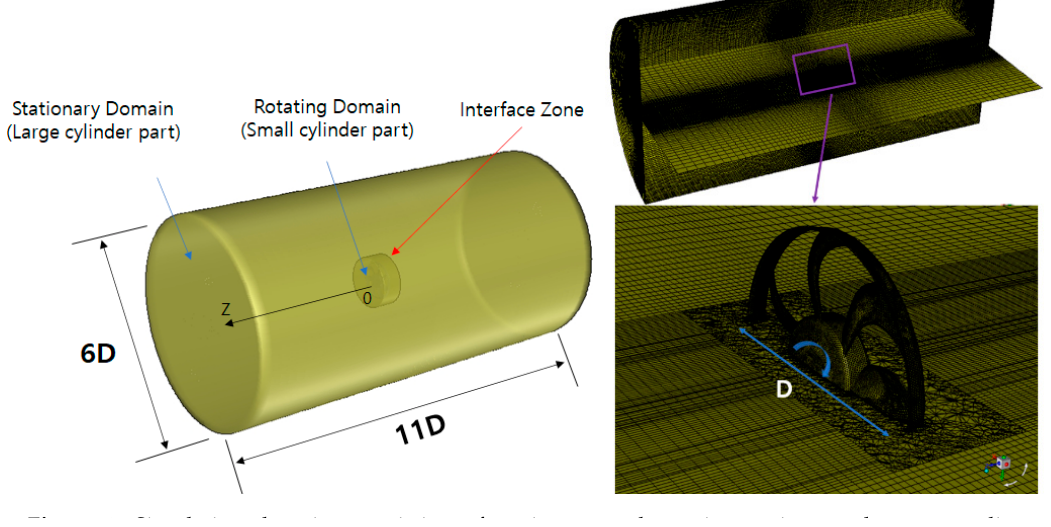
Figure 3. Simulation domains consisting of stationary and rotating regions and corresponding analysis model with hexahedral and tetrahedral elements.